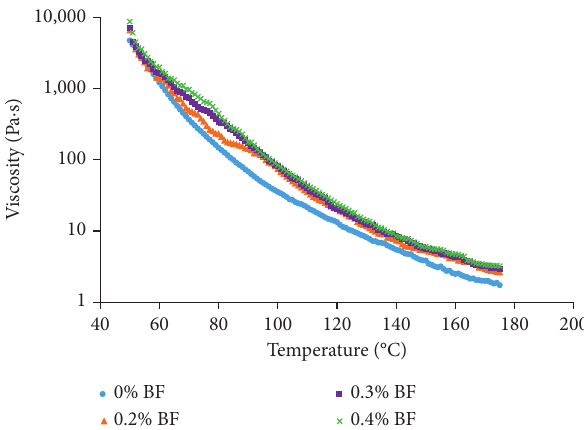
Figure 7: Viscosity CR-BF asphalt binder of different BF contents.